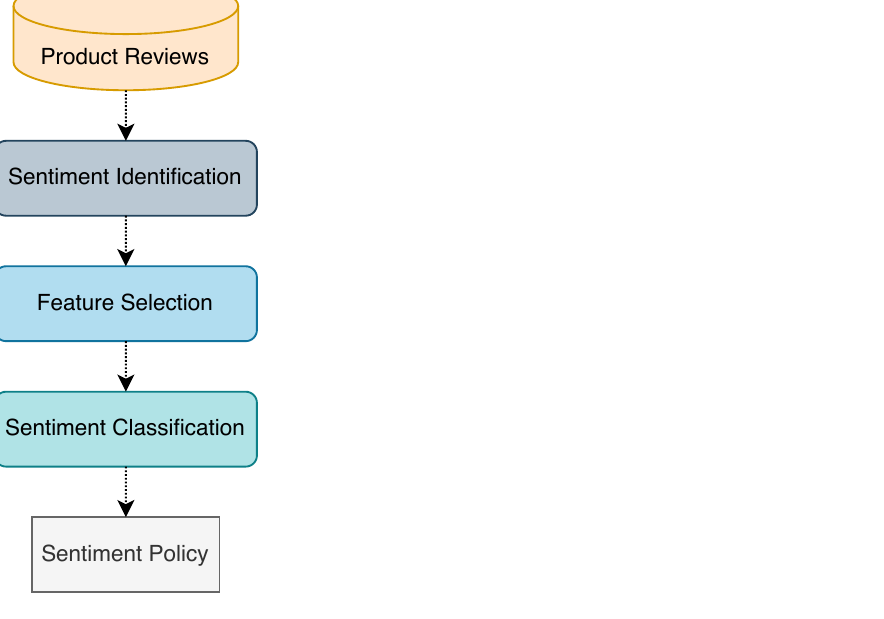
Figure 1. A sample sentiment analysis stages involved in a product